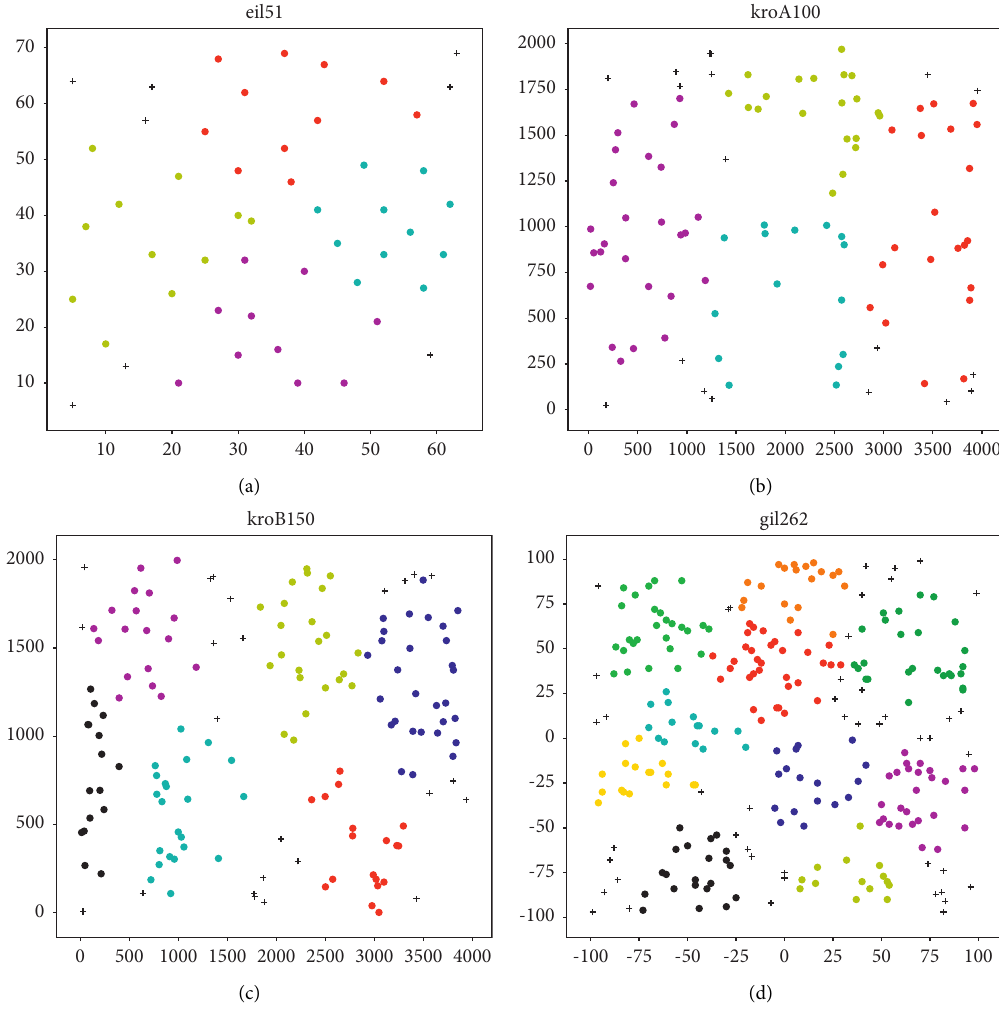
Figure 2: TSP city classification. (a) eil51. (b) kroA100. (c) kroB150. (d)